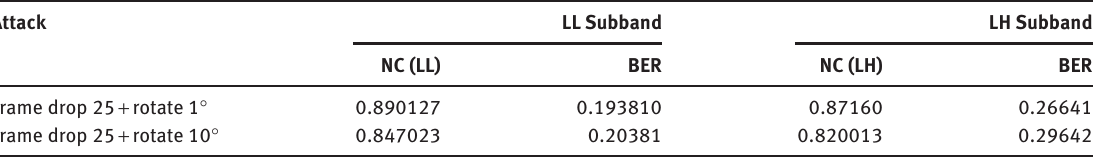
Table 9: Robustness against Multiple